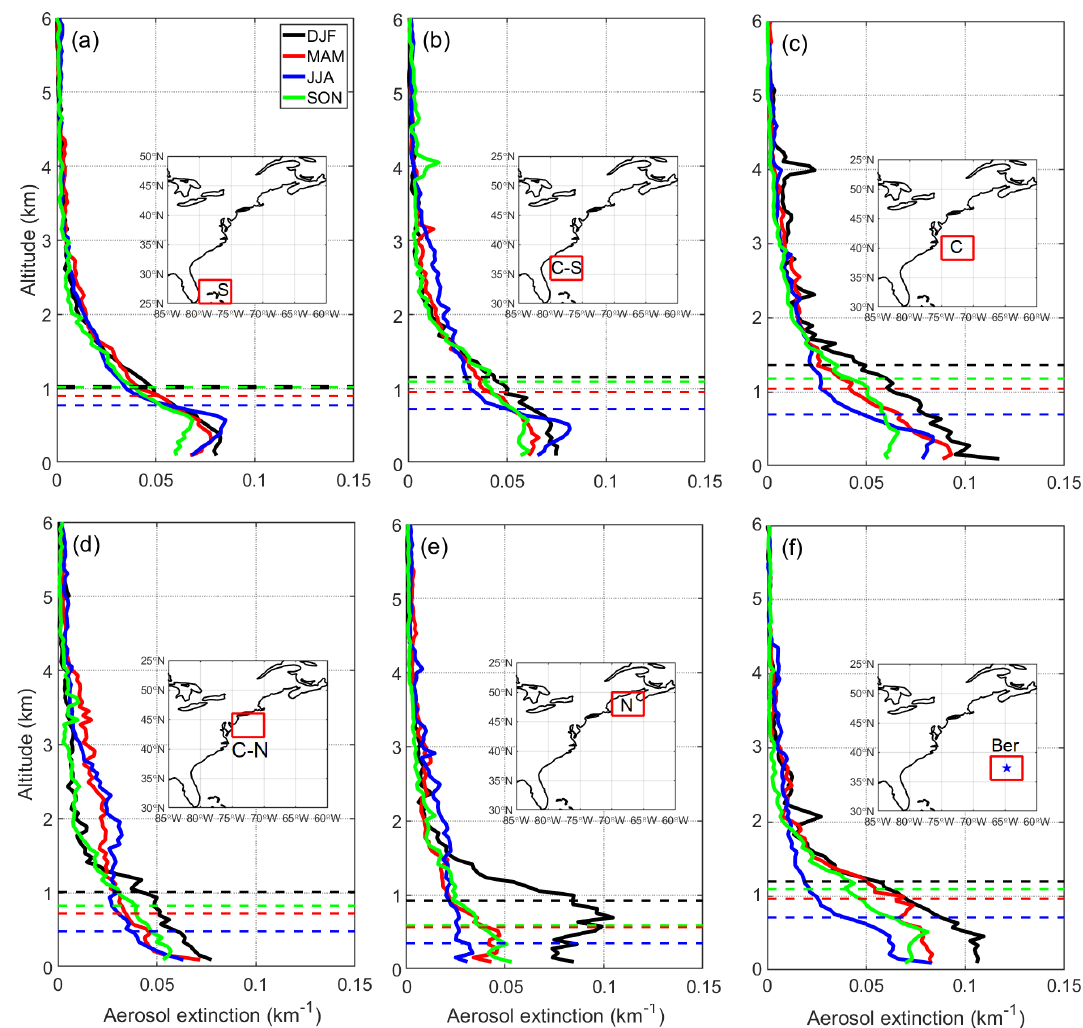
Figure 4. Vertical profiles of CALIPSO aerosol extinction for different seasons in (a) – (f) six different sub-domains of the WNAO. Average seasonal planetary boundary layer heights (PBLH) from MERRA-2 are denoted with dashed